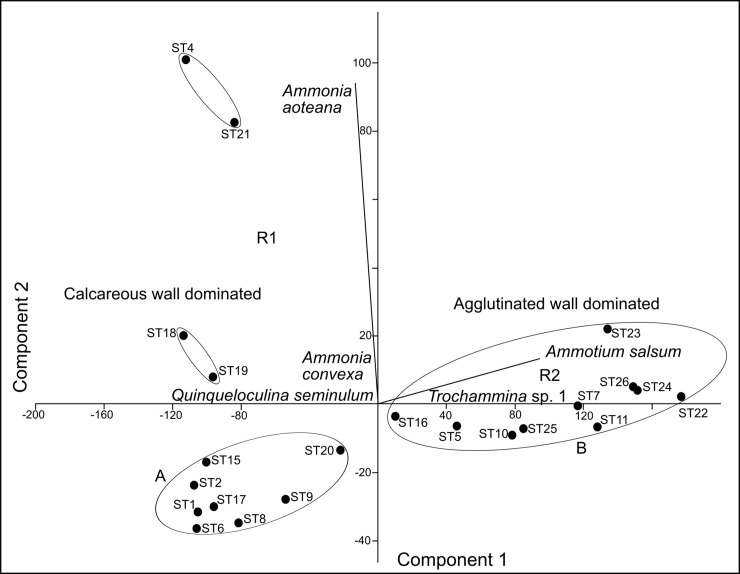
PCA of the foraminiferal fauna of the Lagos Lagoon showing principal components 1 and 2 (A, B and R1, R2 refer to the assemblages defined in Figs 6 and 7).